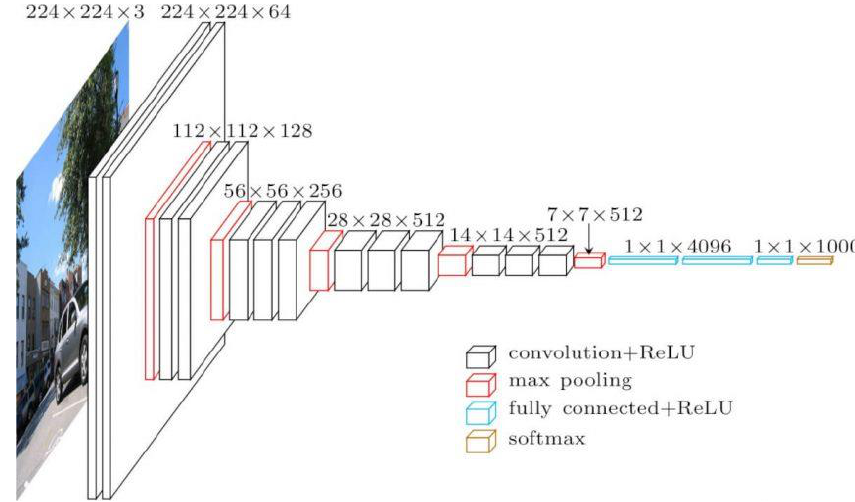
Figure 4. Architecture VGG16.